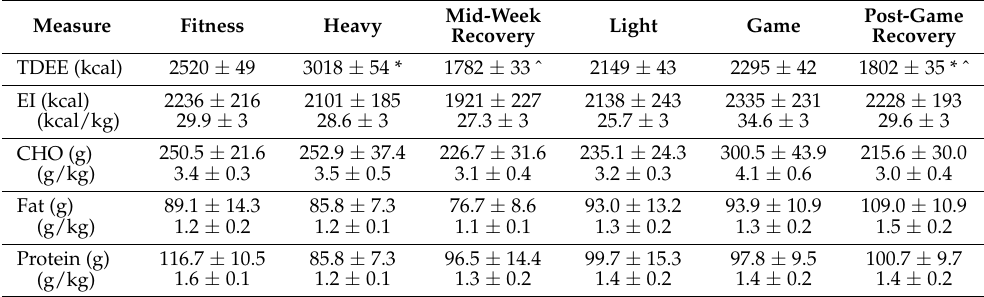
Table 4. Average daily energy expenditure and energy and macronutrient intake over 6 different load days for team.